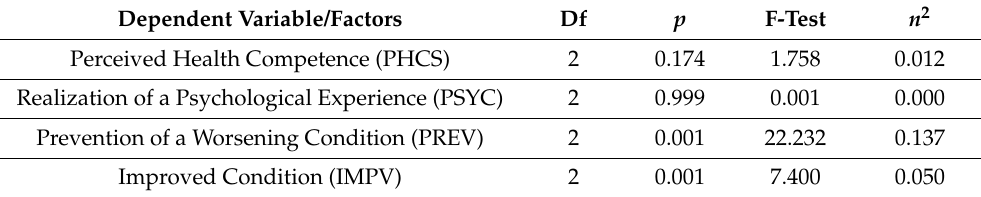
Table 4. MANOVA test of between-subject effects.